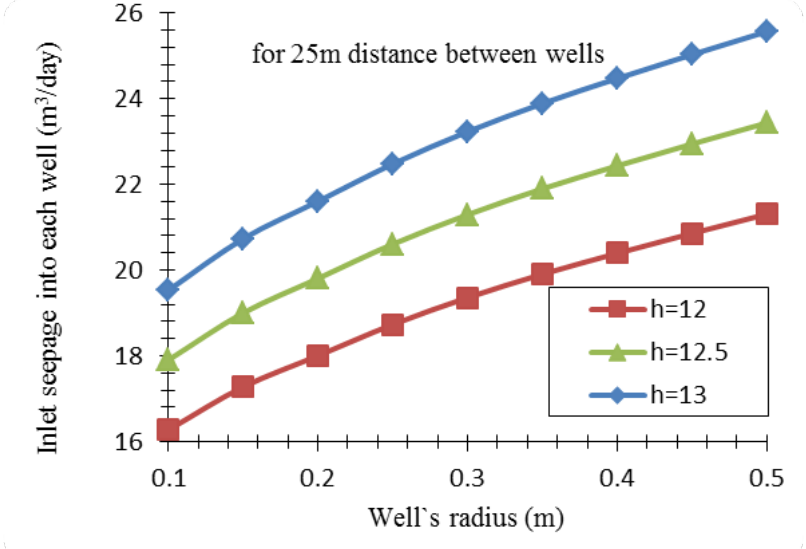
Fig. 10. Effect of upstream reservoir level on inlet seepage flow to each well (25 m distance between each other).